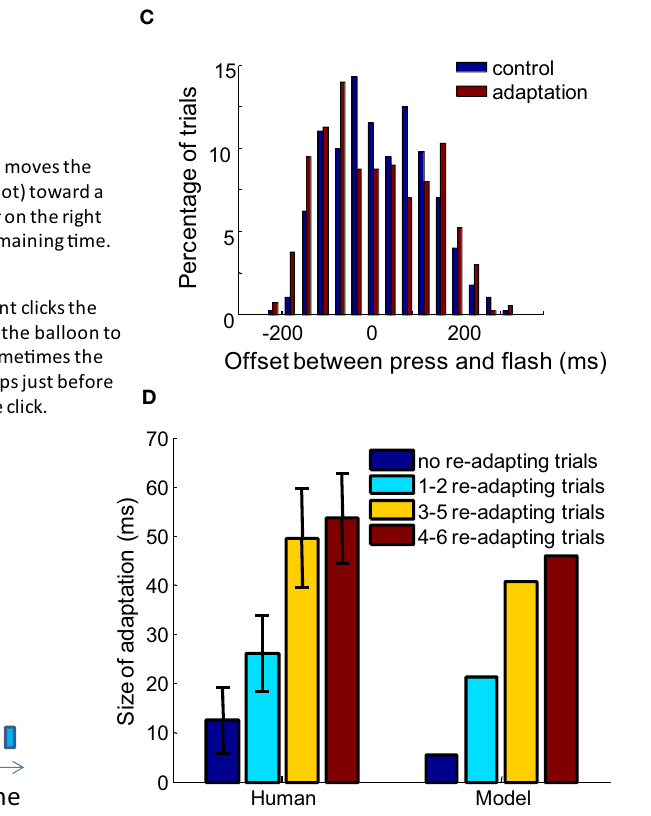
FIGURE 5 |The size of adaptation increases as participants are exposed to more re-adapting trials before each test trial, as predicted by the model. (A) Task of the experiment: participants control the red dot with the mouse, and hit the static green disc representing a balloon. A shrinking blue bar on the right indicates the time left for popping the balloon. In adapting trials, if the participant presses before the time bar shrinks to bottom, the balloon pops (color change to white) with constant delay after the press. In test trials it pops before or after the press is made. Participants only need to judge the order of click and flash for test trials. In the real experiment, the